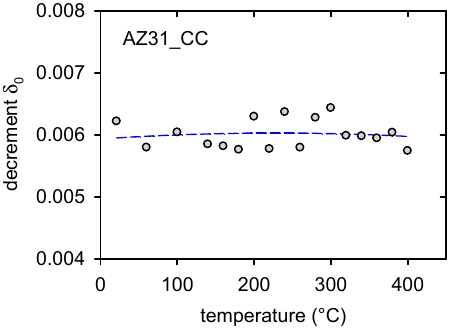
Figure 10. Amplitude independent component of decrement depending on the upper temperature of the thermal cycle.